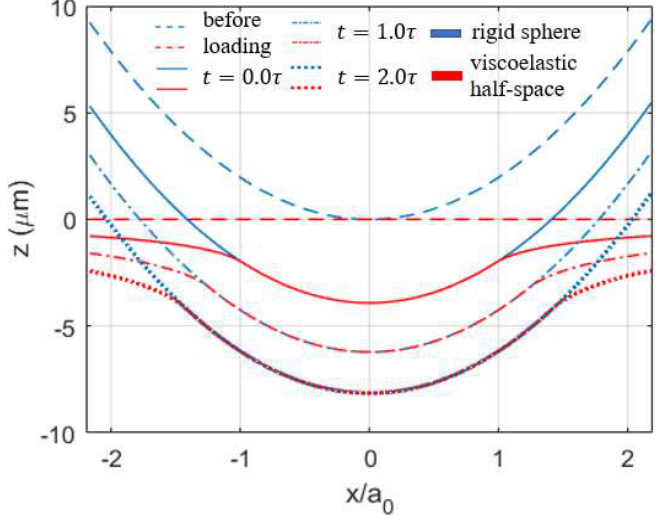
Figure 4. Creep of surface profile at different time points under the input normal load.